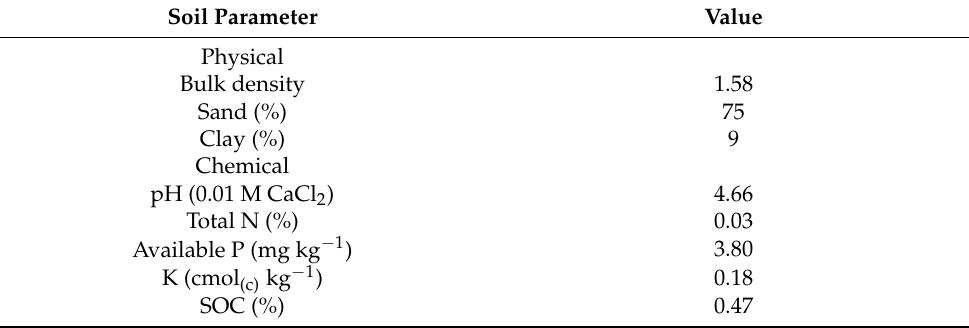
Figure 1. Experimental site location. Table 1. Initial topsoil (0–45 cm) characteristics at experimental